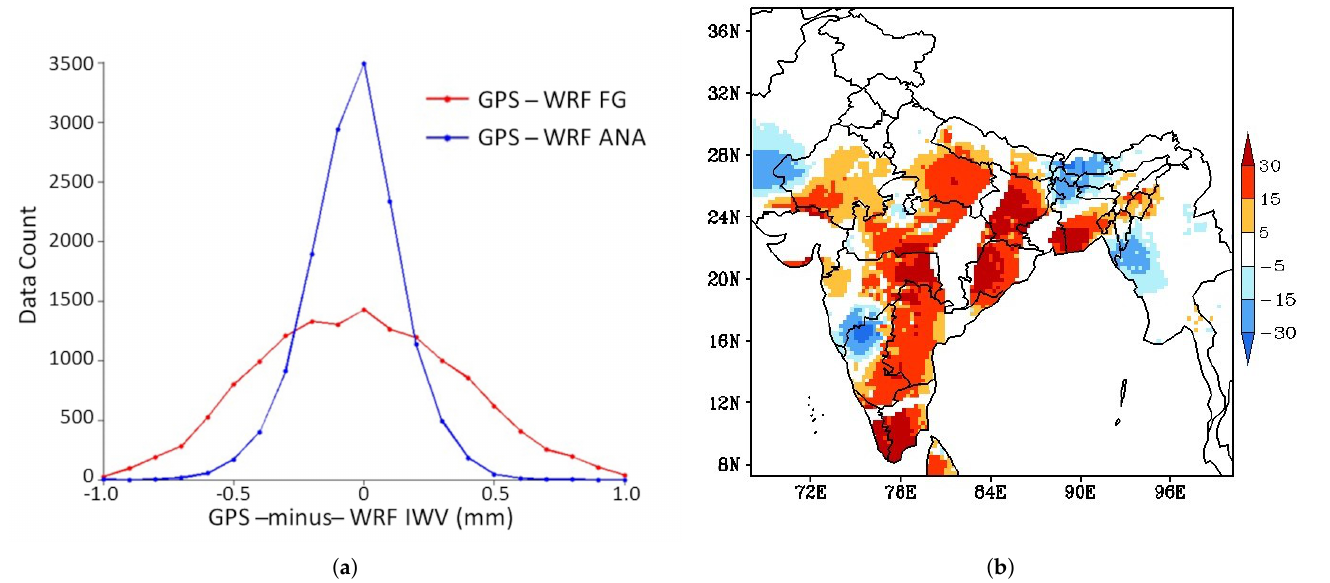
Figure 6. ( a ) (left) Comparison of histograms of IWV First-Guess (FG) and Analysis (ANA); and ( b ) (right) Map showing the change IWV analysis error (in percent) after assimilation. Positive values correspond to decrease in RMSE (improvement in skill) and negative values correspond to increase in RMSE (degradation in